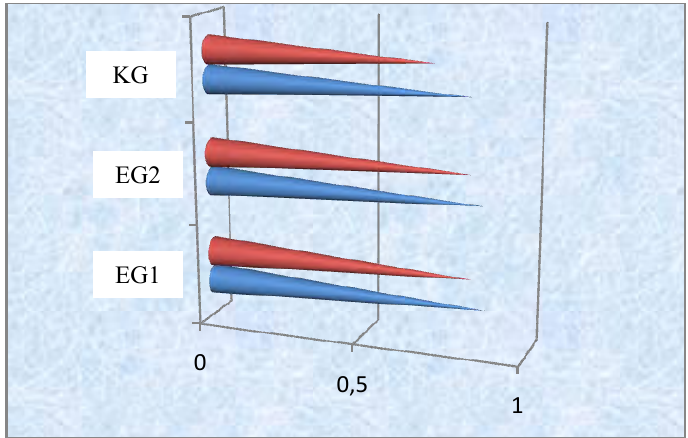
Fig.1. Preciseness of visual information’s processing in control and experimental